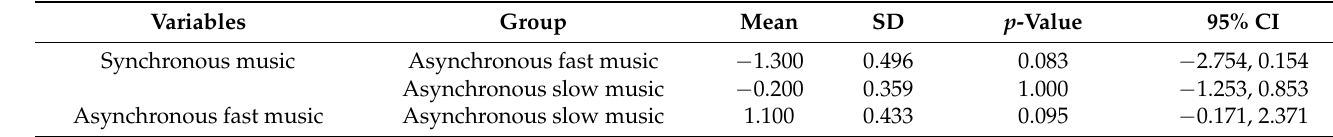
Table 9. Table pairwise comparisons RPE 30 min group